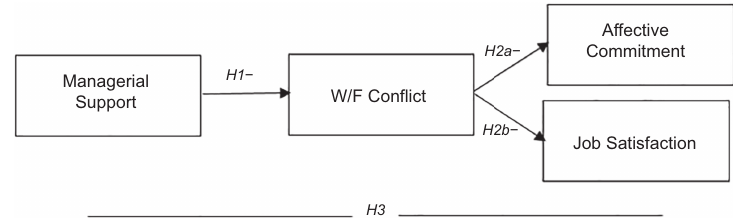
Figure 1. Theoretical